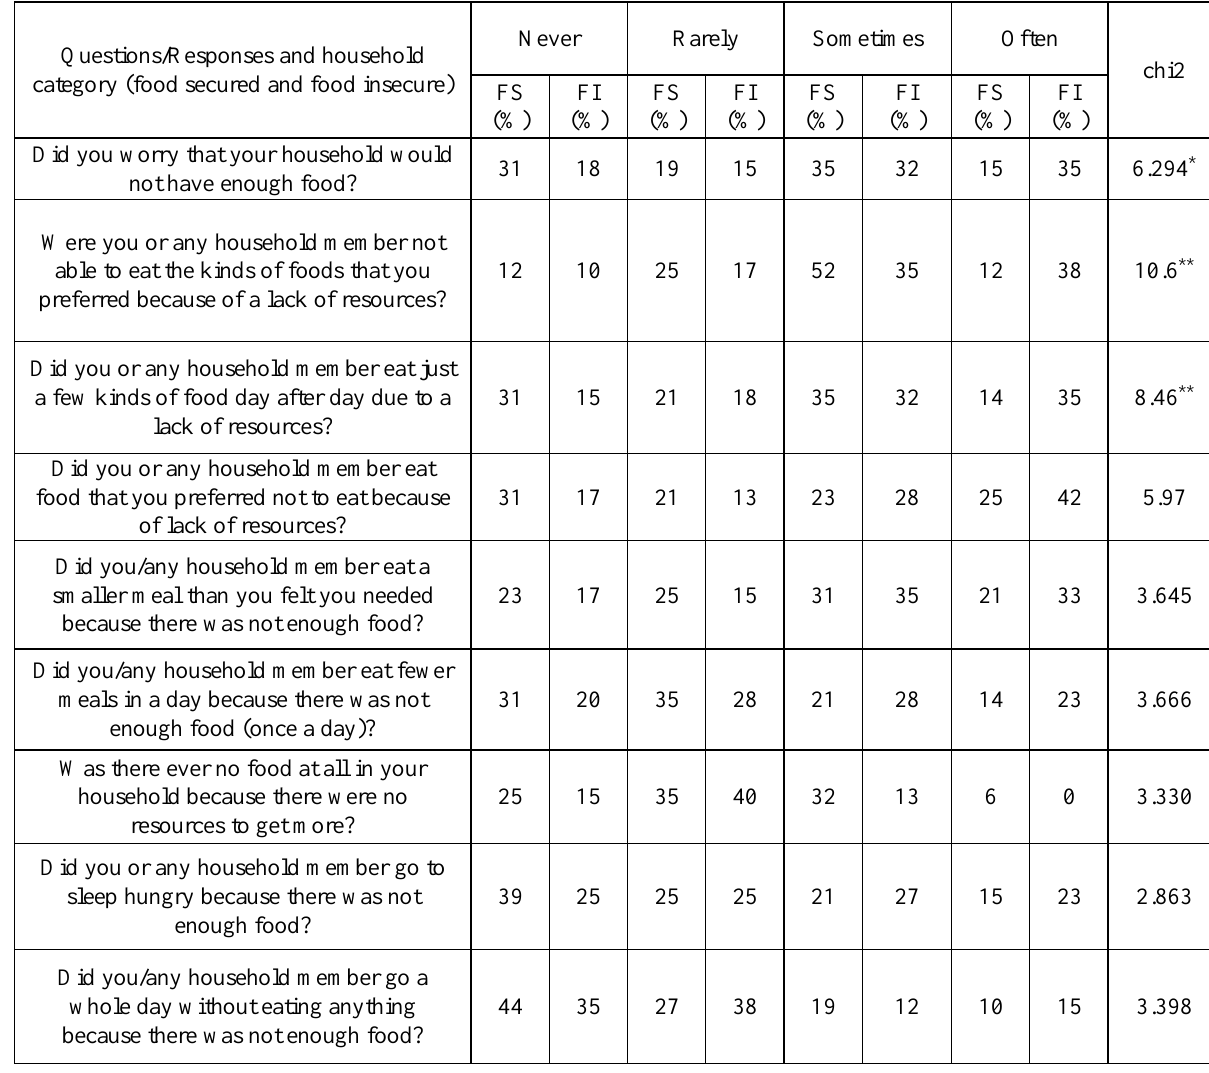
Table 11. Percentage of sample households responded as “Yes” for the food insecurity access scale questions that focus on food consumption for family need in the last 12 months Questions/Responses and